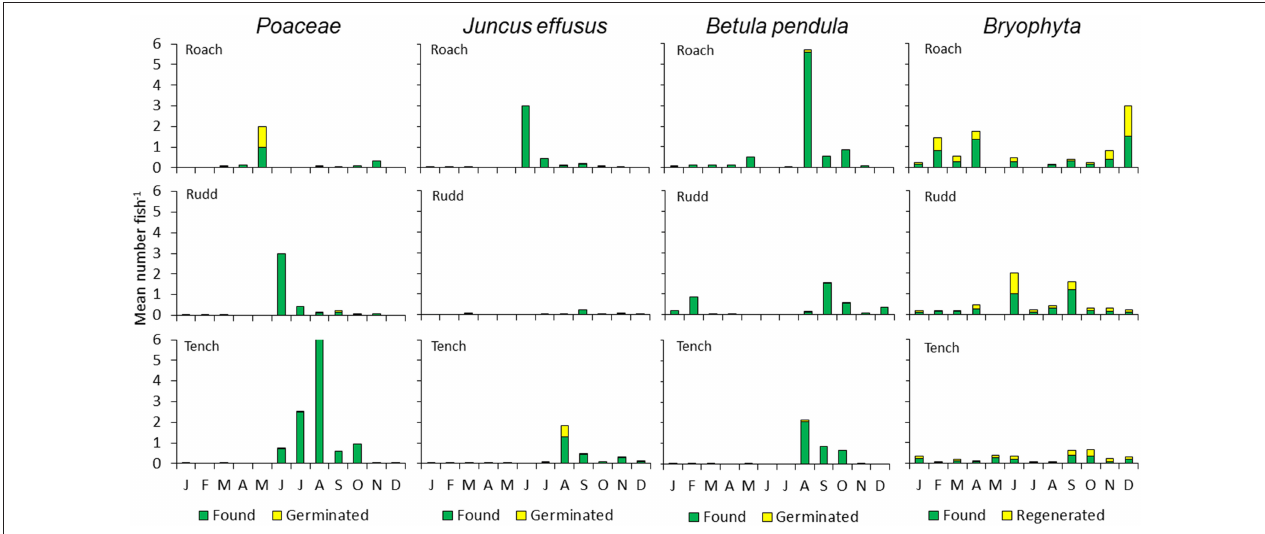
FIGURE 4 | Monthly mean number of seeds and bryophyte fragments per fish for Roach, Rudd, and Tench. The proportions of germinated seeds or regenerated fragments are indicated for seeds or fragments of grasses ( Poaceae ), Juncus effusus , Betula pendula and Bryophyta . J–D (January–December, months during the research